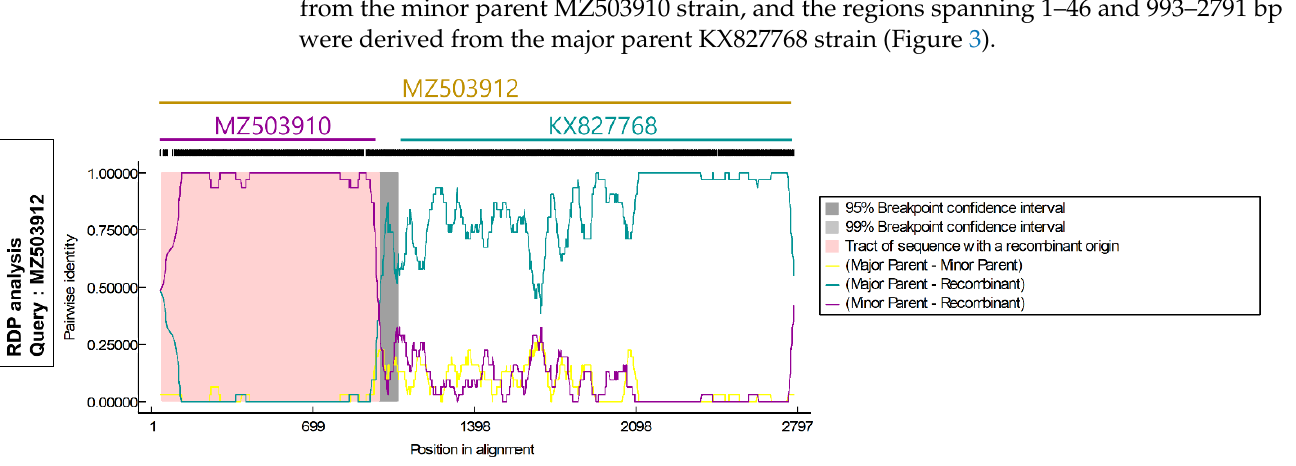
Figure 3. Recombination analysis using full-length TTCaV genome. MZ503912 was considered a recombinant of MZ503910 strain (minor parent) isolated from Republic of Korea and KX827768 strain (major parent) isolated from China.